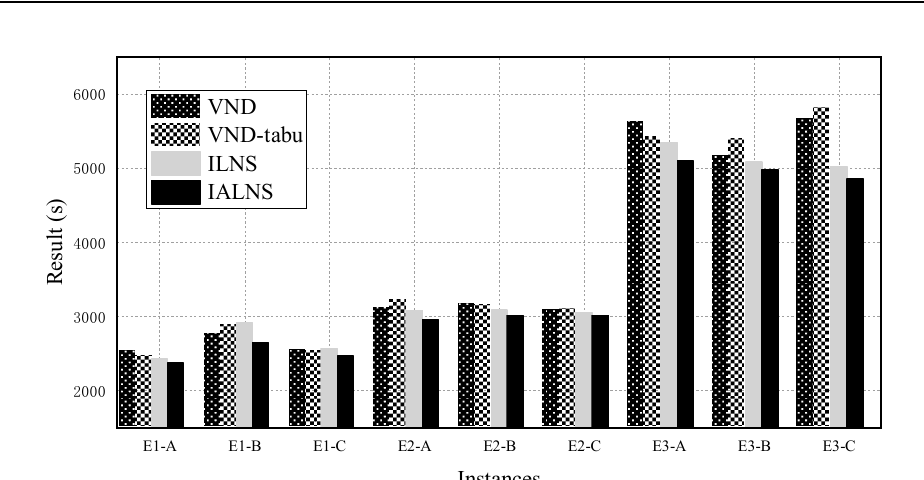
Figure 12. Comparison of results of different algorithms.